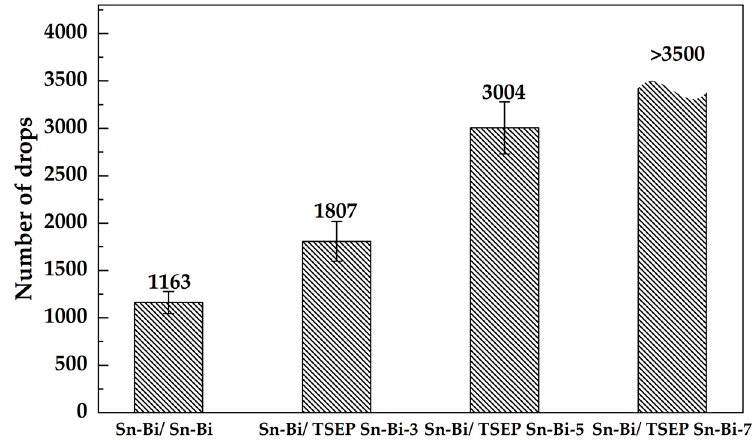
Figure 5. Drop test results for Sn–Bi/Sn–Bi and Sn–Bi/TSEP Sn–Bi-x solder joints after the board level drop test.